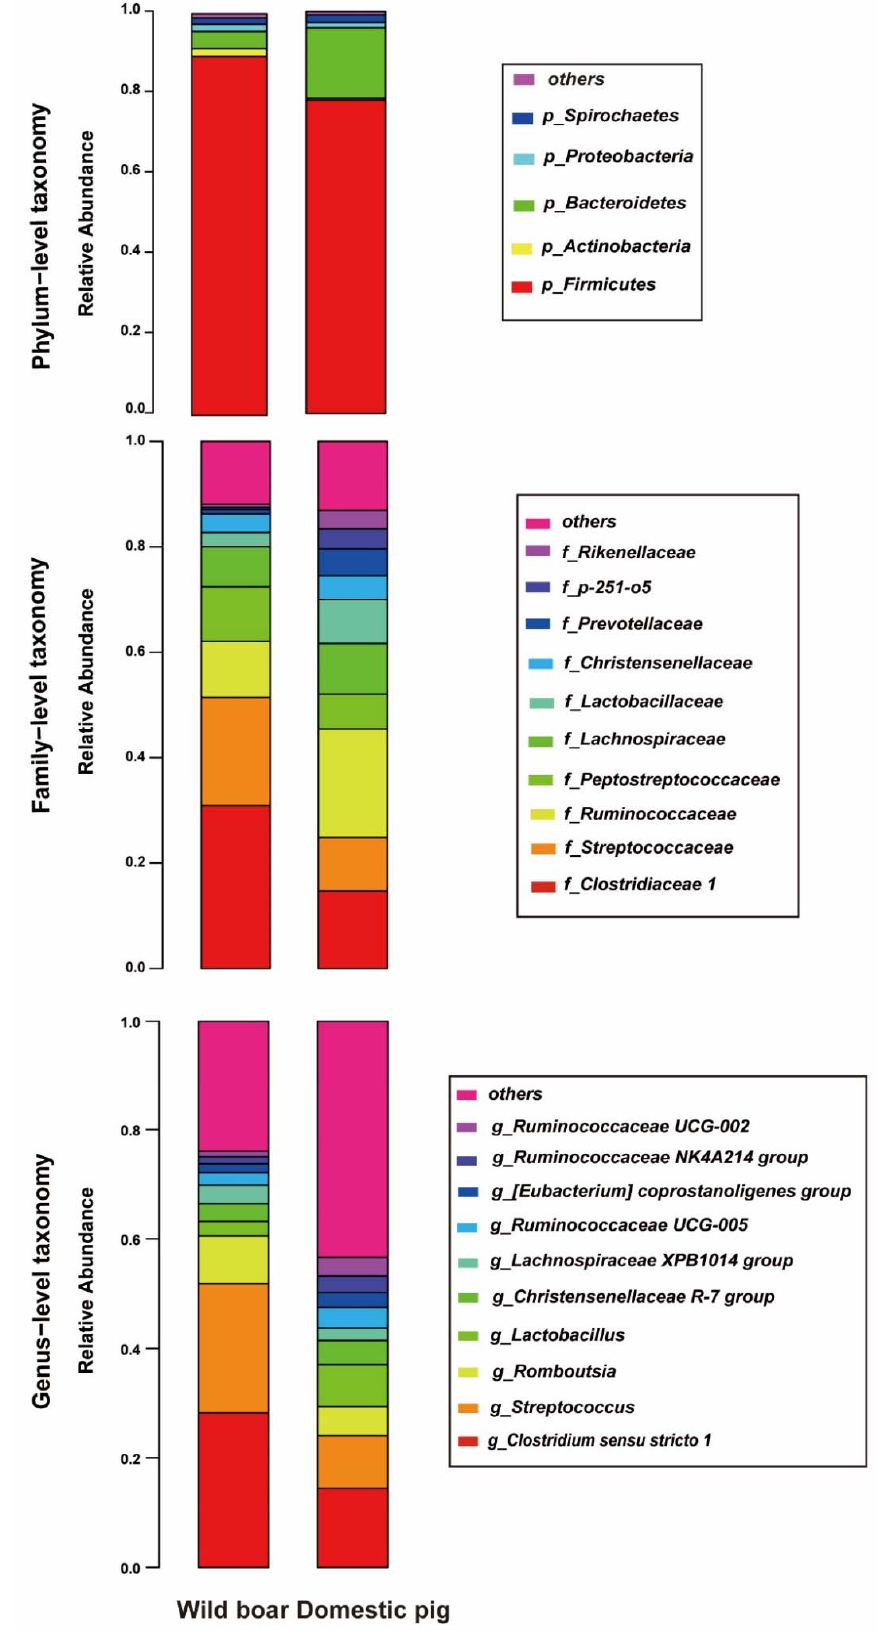
Figure 1. The phylum, family, and genus classification based on 16S rRNA V3 ‐ V4 sequences.